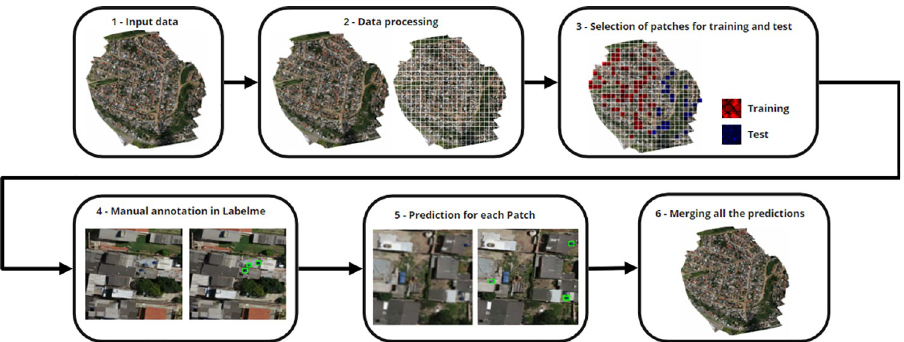
Fig 4. Methodology flowchart for the water tanks detection. Satellite images published under a CC BY license, with permission from G drones, original copyright 2016.